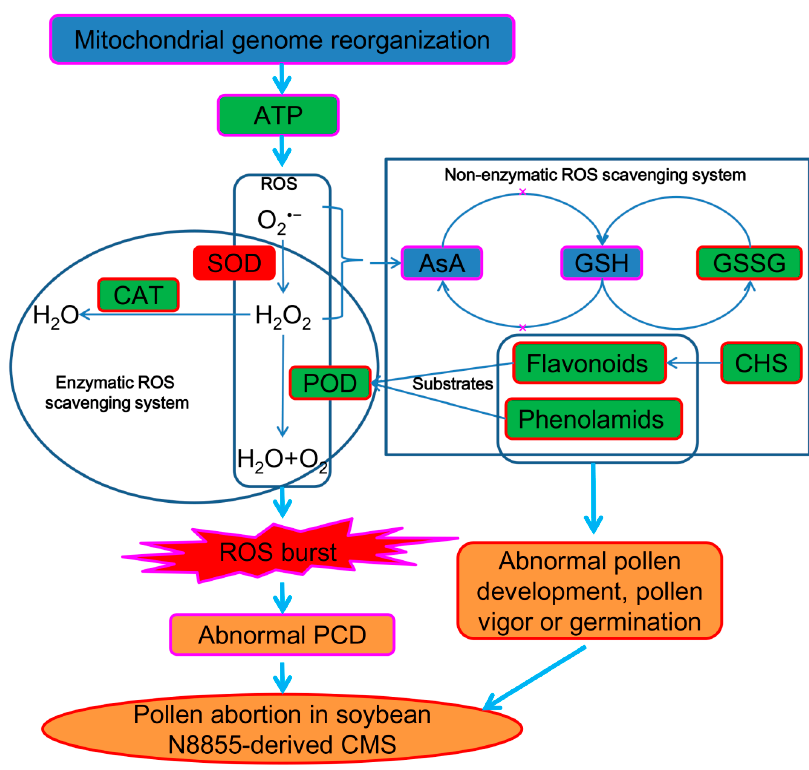
Figure 8. A proposed model for ROS burst and ROS scavenging system deficiency in soybean CMS-N8855. Pink and bright red boxes indicate a conclusion supported by experimental evidence in reports from previous studies and this study, respectively. The up-regulated and down-regulated of enzyme activity or metabolite content are in red and green, respectively.